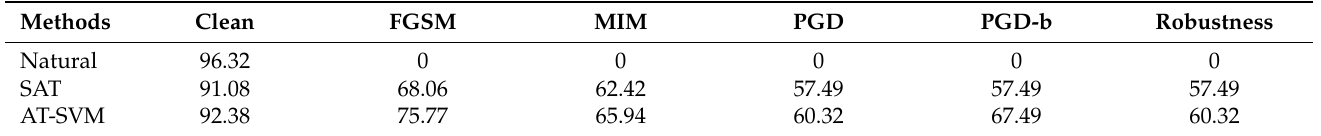
Table 4. Test accuracy of ResNet-18 on the SVHN dataset.